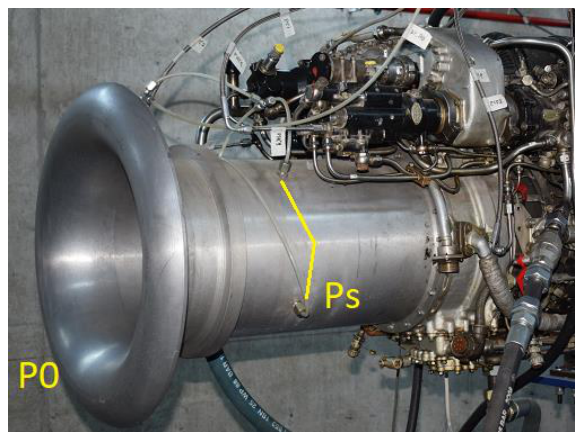
Figure 8. TV2-117A bellmouth instrumentation.